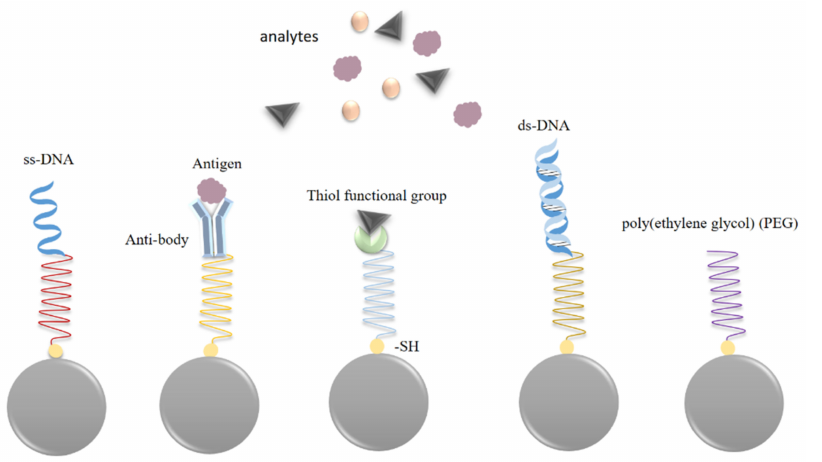
Figure 5. Different functionalisation thiols applied to metal nanoparticles: thiol-ss-DNA, thiol- anti-body, thiol-ds-DNA,